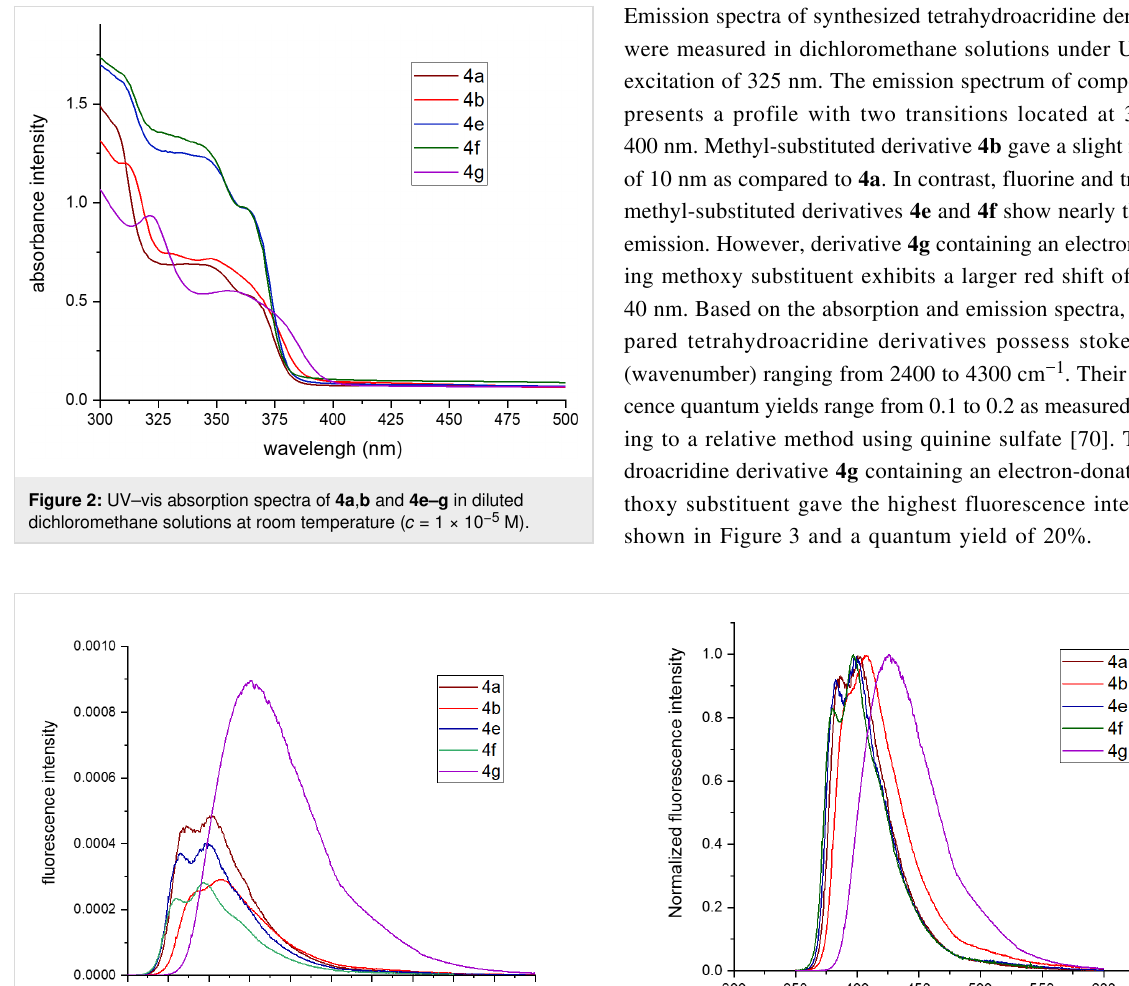
Emission spectra of synthesized tetrahydroacridine derivatives were measured in dichloromethane solutions under UV-laser excitation of 325 nm. The emission spectrum of compound